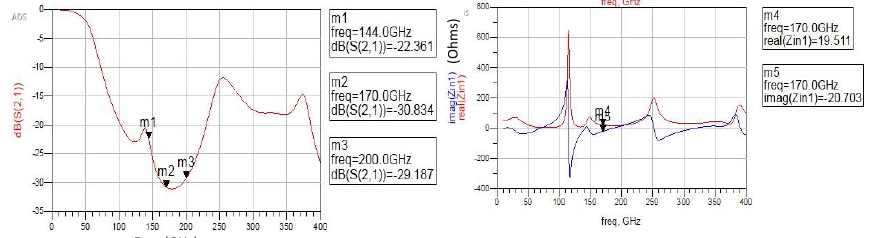
Figure 5 : The ADS Simulation result at 170 GHz (a) for transmission coefficient (S21) where the minima depicts the maximum power transfer, and (b) for input impedance of the low pass filter where its minimum value signifies its easy passage from source to